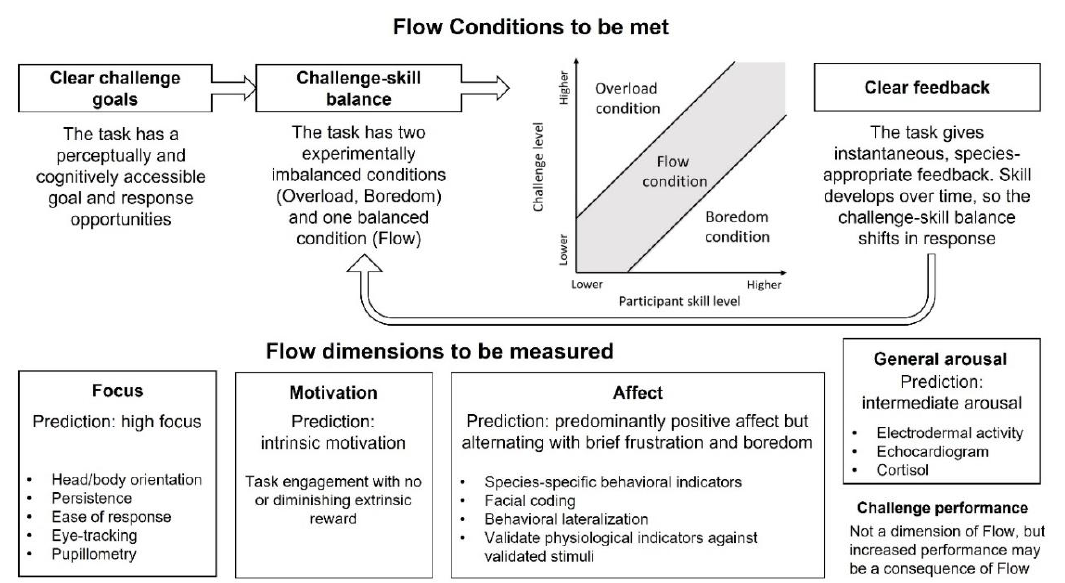
The Comparative Study of Flow in Great Apes and Humans in a Computerized Challenge